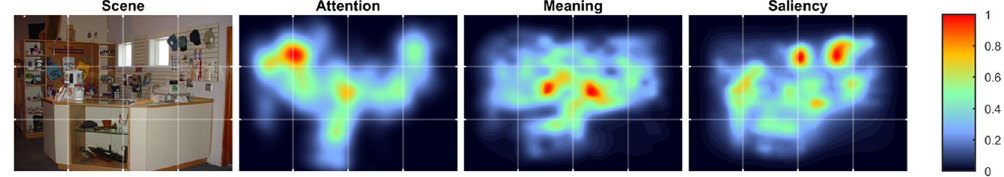
Figure 1. An example scene with its attention map empirically determined from viewer fixations, along with its meaning and saliency maps. (Grid lines are included for ease of comparison and were not present in the